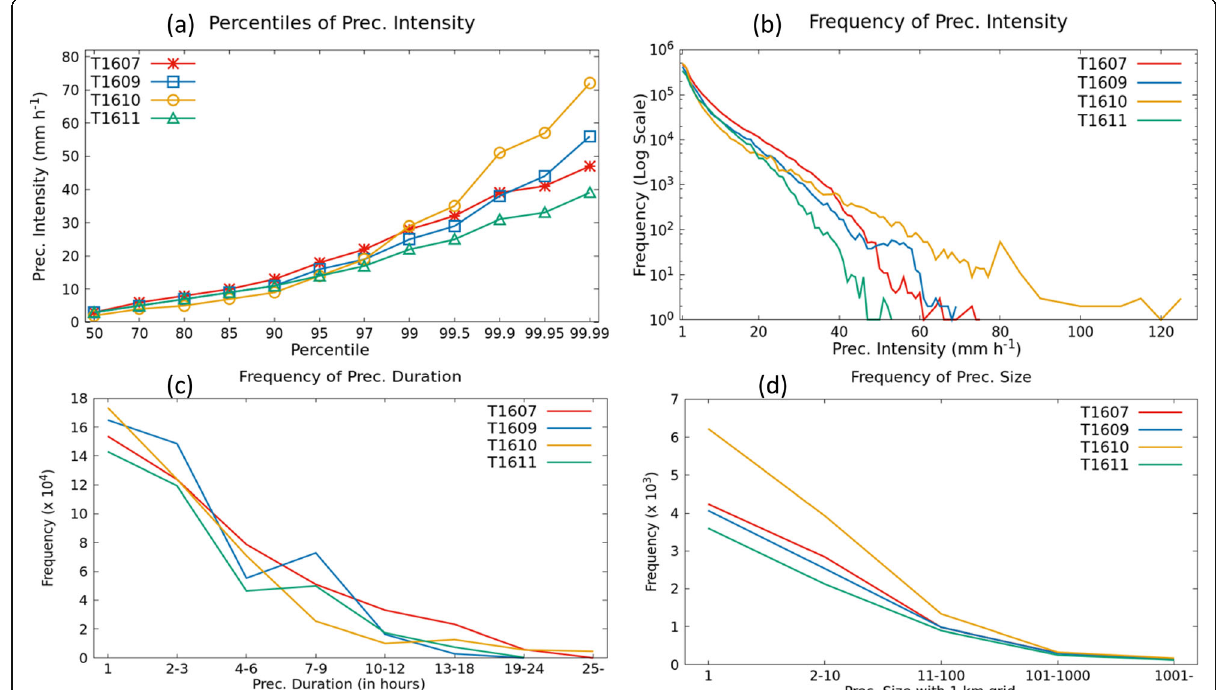
Fig. 2 Precipitation a percentiles, b frequency distribution, c duration, and d size. Results in ( c ) and ( d ) correspond to the frequency distributions of group of precipitation durations and precipitation sizes